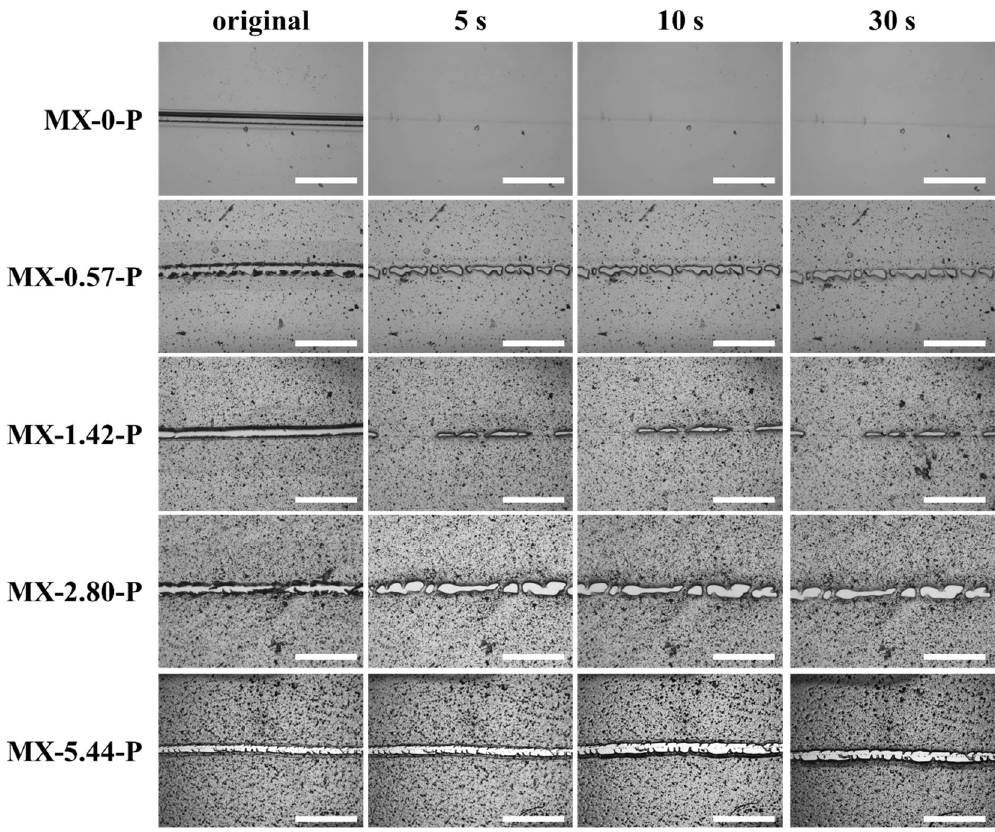
Figure 8. Optical images of MX-0-P–MX-5.44-P coatings having cracks heated at 150 °C for different time periods. No leveling agent was used. Scale bar = 300 μm.